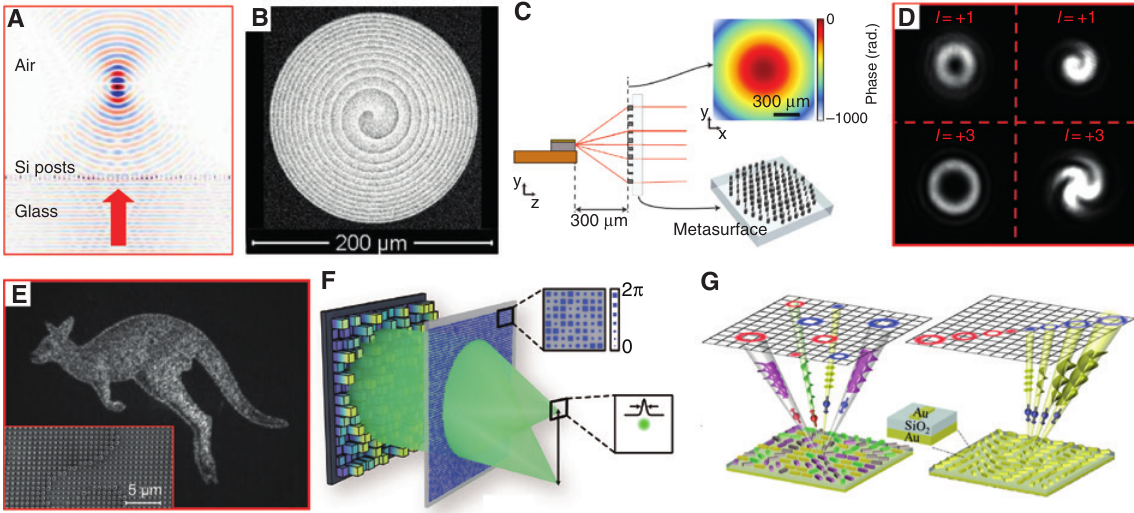
Figure 6: Wavefront shaping with phase